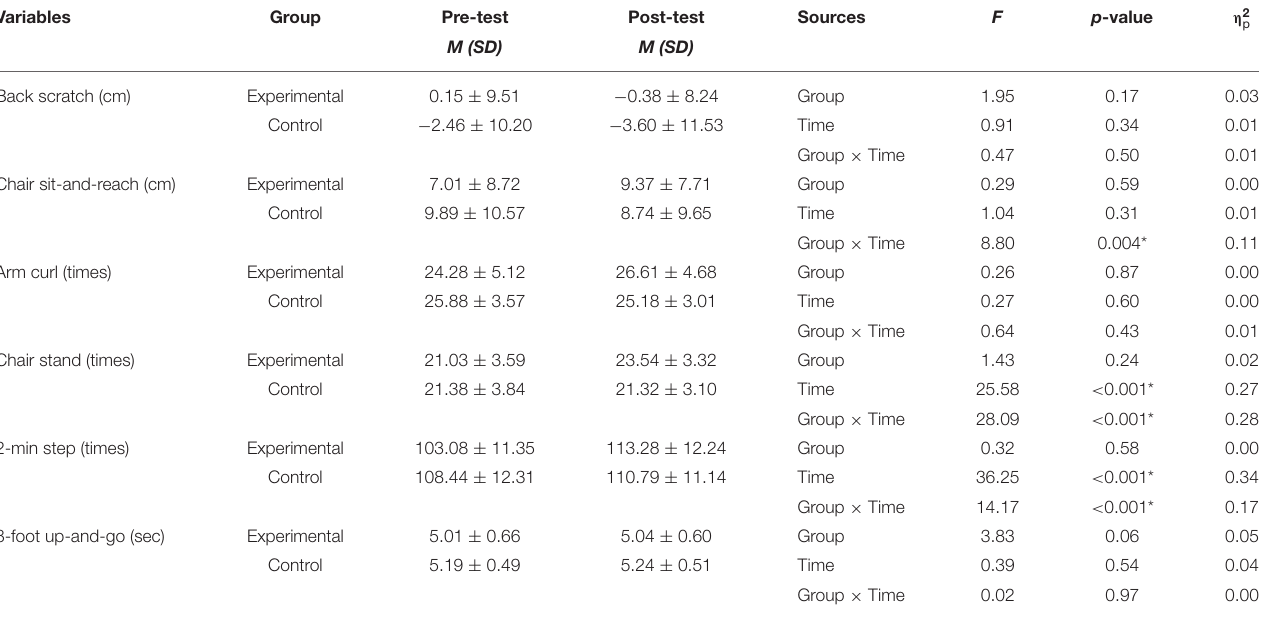
TABLE 2 | Summary of the functional fitness of